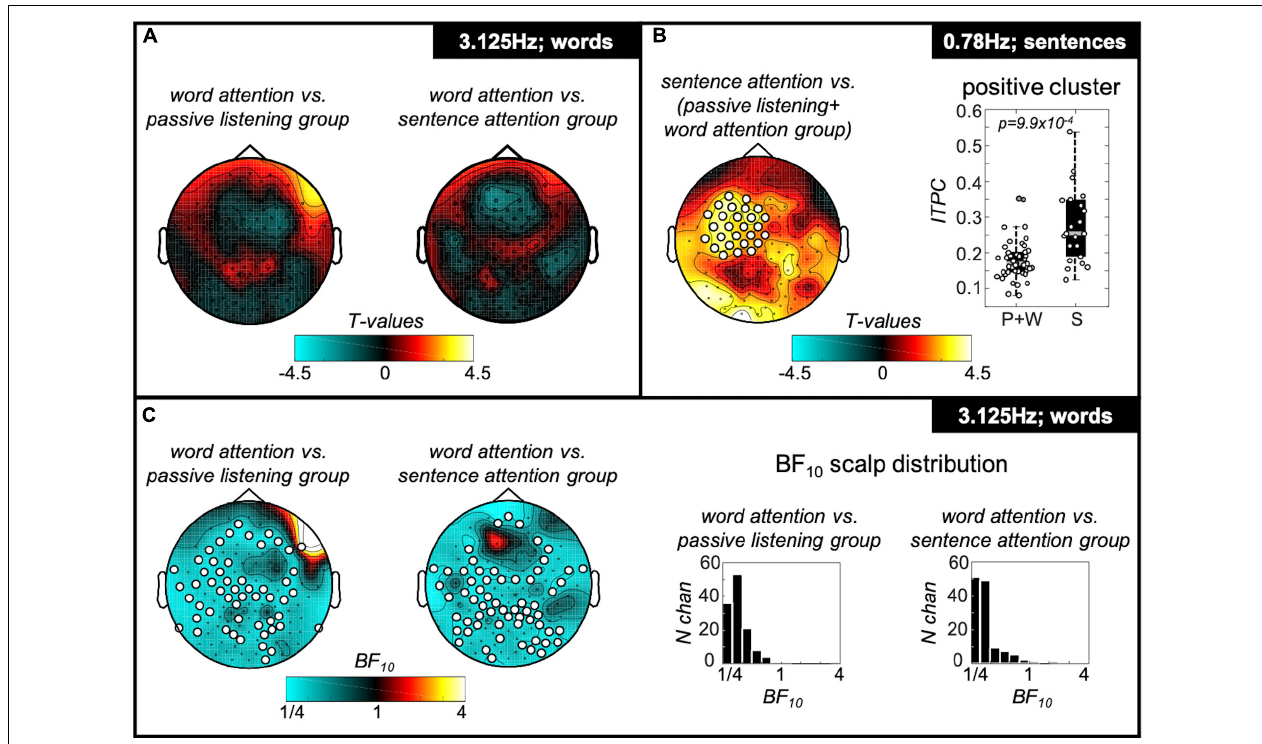
FIGURE 4 | Spatial clusters specific for attentional manipulation. (A) Comparison of the word tracking strength between participants who paid attention to individual words (word group) with those participants who did not (passive and sentence group). Topography plots show colour-coded T-values of these comparisons. No significant cluster was found. (B) Comparison of the sentence tracking strength between participants who paid attention to individual sentences (sentence group) with those participants who did not (passive and word group). Topography plot shows colour-coded T-values of this comparison. A significant positive cluster was found, located over left-lateralised fronto-temporal recording sites ( p = 9.9 × 10 − 4 ). These clusters are further illustrated in the boxplots on the right side of the panel, showing inter-trial-phase-coherence values for participants of passive + word group (“P+W”) and of sentence group (“S”) for the two clusters. The central gray line marks the median, and the bottom and top edges the 25th and 75th percentiles of the data, respectively. Error bars extend to the extreme values, excluding outliers, and circles show data of the individual participants. Filled gray circles represent outliers. (C) Results of Bayesian equivalent two-sample t -tests. Topographies show that most electrodes in the contrast word vs. passive group as well as word vs. sentence group show substantial evidence in favour of the Null and thus suggest there is no difference in tracking strength at the word rate between these groups. Right side of C shows distributions of BF10 over all electrodes on the scalp for both